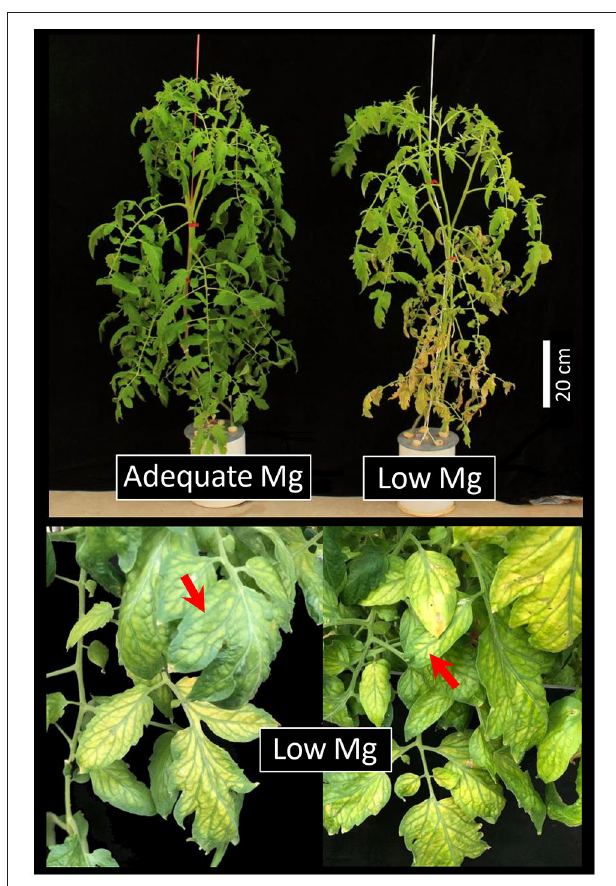
FIGURE 2 | The visual Mg deficiency symptoms on tomato seedling. Under low Mg supply, interveinal chlorosis usually first appears on older, fully expanded (mature) leaves, and gradually encompasses younger leaves as Mg deficiency becomes more severe. Where adequate and low Mg were applied as 1.0mM and 0.02mM Mg, respectively, in the nutrient solution. Other details on plant growth have been described elsewhere ( Ishfaq et al., 2021).